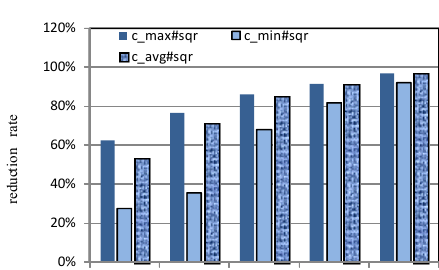
Figure 12. The reduction rate of outer points.